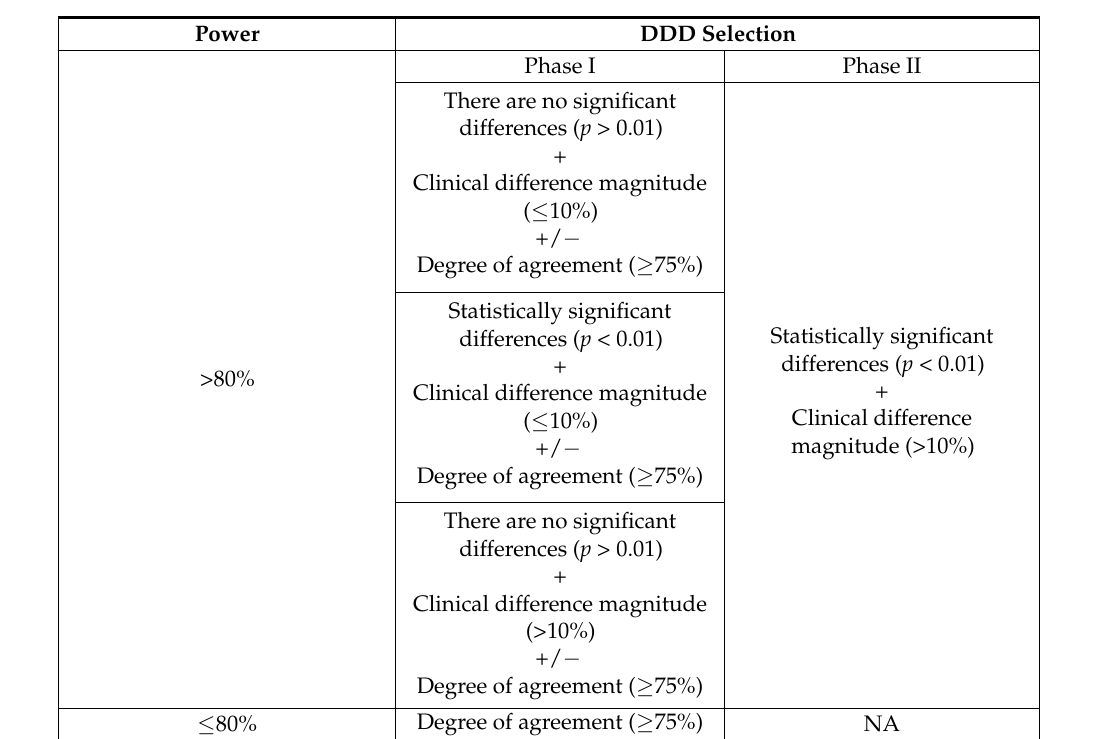
Table 1. DDD selection